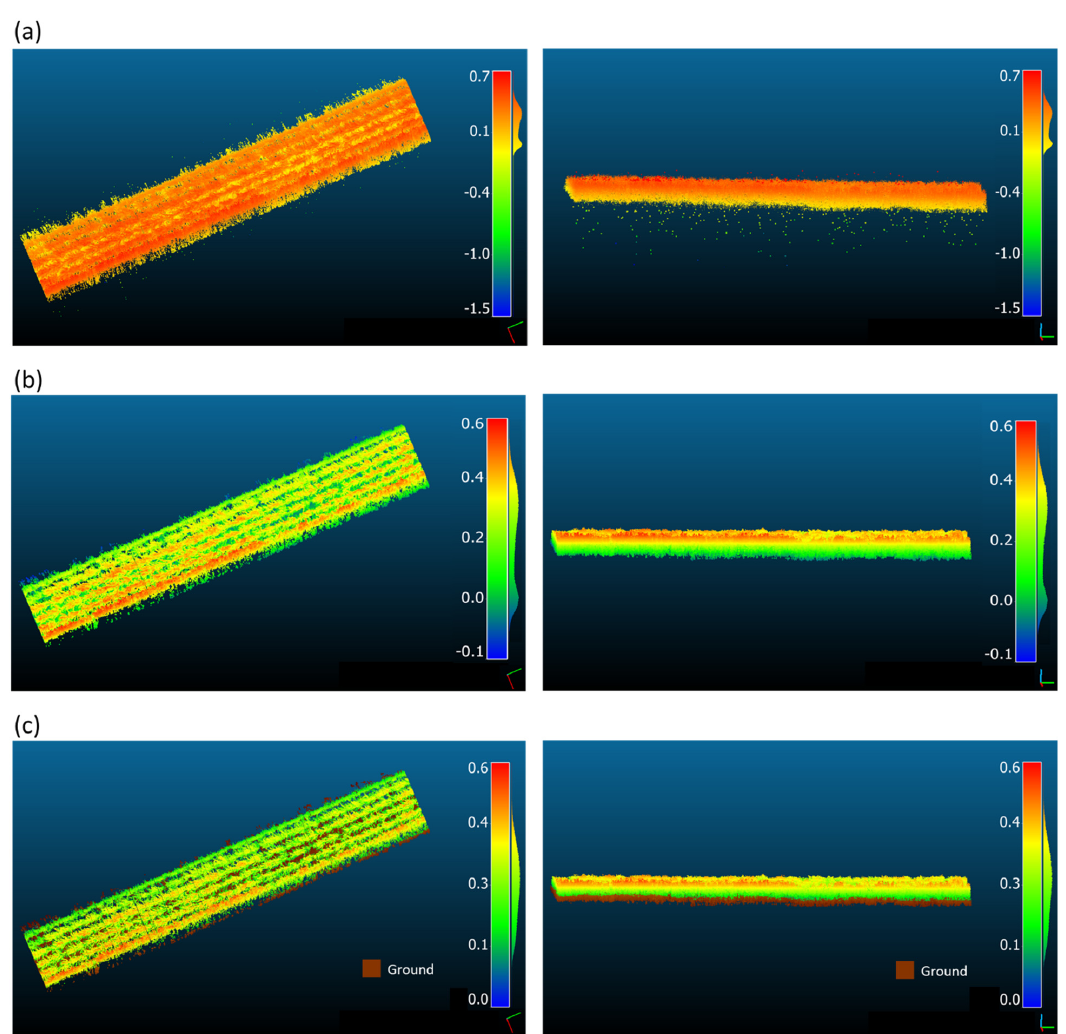
Figure 5. Results of point cloud data processing on an exemplar dataset of 2 × 10 m with nadir (left) and side views (right). From top to bottom: ( a ) raw point cloud, ( b ) filtered points after outlier elimination, and ( c ) classification into ground and above ground points. The colour scale is based on the point height value in m. The side histogram bars represent the amount of points per height value.